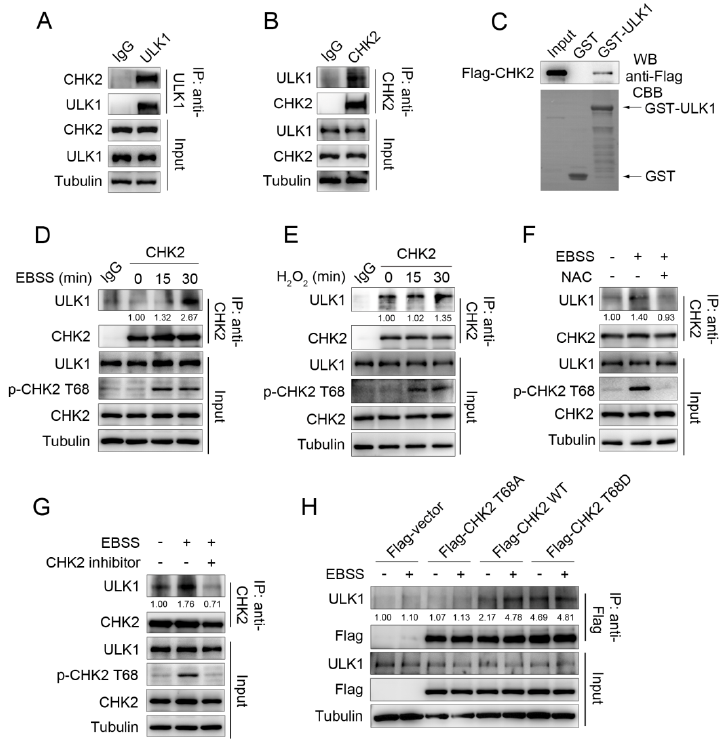
Figure 1. ULK1 is a physiological substrate of CHK2. ( A , B ) Immunoprecipitation assays testing the endogenous interaction between CHK2 and ULK1 in HCT116 cells. Lysates were immunoprecipi- tated with ULK1 ( A ) or CHK2 ( B ) antibody. The immunoprecipitates and lysates were analyzed by Western blot. ( C ) CHK2 binds with ULK1 in vitro. GST pull-down assays were performed by in- cubating purified GST or GST-ULK1 with invitro-translated flag-tagged CHK2. Arrows indicate GST and GST-ULK1 bands. ( D ) Lysates from HCT116 cells treated with EBSS were immunopre- cipitated with CHK2 antibody or rabbit IgG. The immunoprecipitates and lysates were analyzed by Western blot. ( E ) Lysates from HCT116 cells treated with H 2 O 2 (500 μM) were immunoprecipitated with CHK2 antibody or rabbit IgG. The immunoprecipitates and lysates were analyzed by Western blot. ( F ) Lysates from HCT116 cells pretreated with NAC (SIGMA, A7250, 2 mM) for 3 h and then cultured for 30 min in EBSS starvation were immunoprecipitated with CHK2 antibody. The ex- pression of p-CHK2 Thr68, CHK2, and ULK1 was detected by immunoblotting. ( G ) Lysates from HCT116 cells pretreated with CHK2 inhibitor (SIGMA, C3742, 20 μM) for 4 h and then treated with EBSS for 30 min were immunoprecipitated with CHK2 antibody. The expression of p-CHK2 Thr68, CHK2, and ULK1 was detected by immunoblotting. ( H ) Lysates from HCT116 cells expressing theindicated plasmids, treated or untreated with EBSS, were immunoprecipitated with FLAG an- tibody. The immunoprecipitates and lysates were analyzed by Western blot with the indicated an- tibodies. Quantitative analysis for the binding intensity of ULK1 are shown. 3.2. CHK2 Phosphorylates ULK1 at Ser556 The protein modification of ULK1, especially the phosphorylation modification, is significant in its involvement in autophagy initiation. To determine whether CHK2 couldphosphorylate ULK1, we first utilized an optimal CHK2 substrate motif to search for possible amino acids sequences containing conservative candidate target sites in the